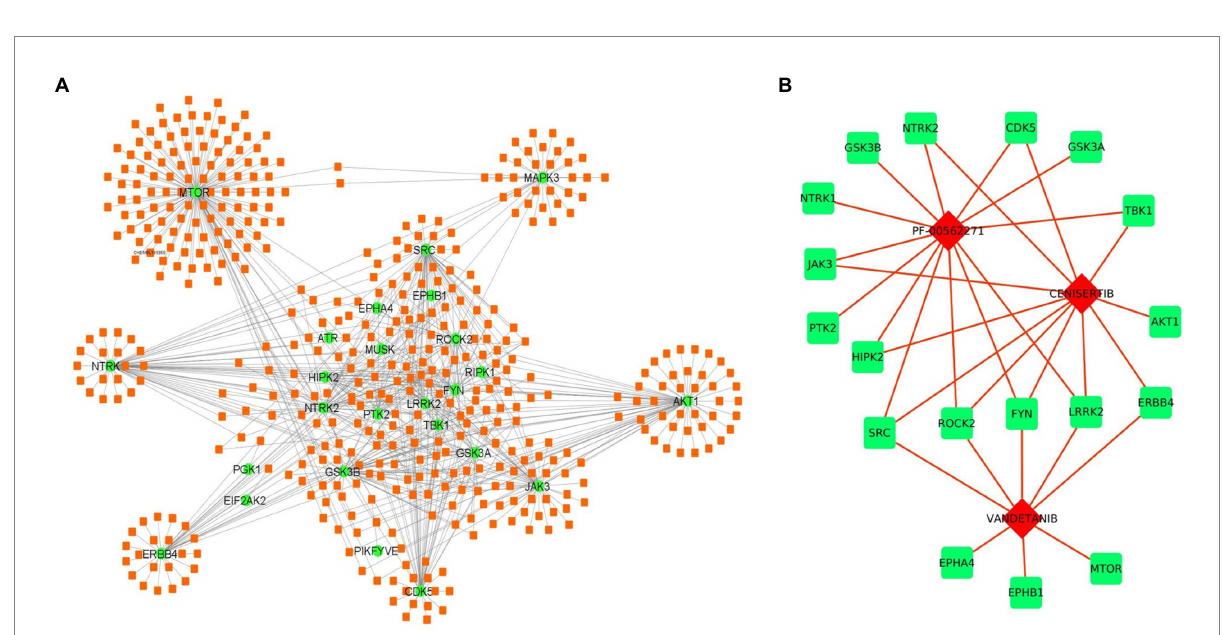
FIGURE 6 Drug-kinase interaction network. (A) The 36 kinases (Green) showed interaction with 468 drugs (Orange) from the DGI database. (B) Drug-kinase interaction of the top 3 selected drugs having association with the majority of kinases in the